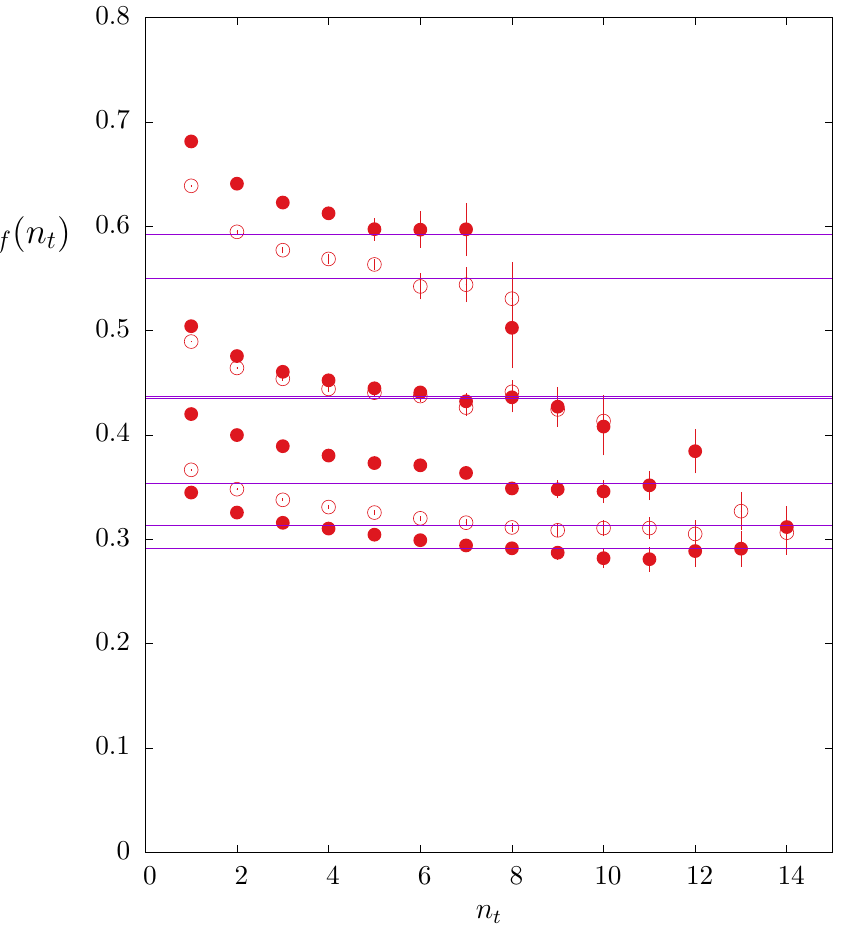
p (cid:27) (cid:24) 4 : 2,